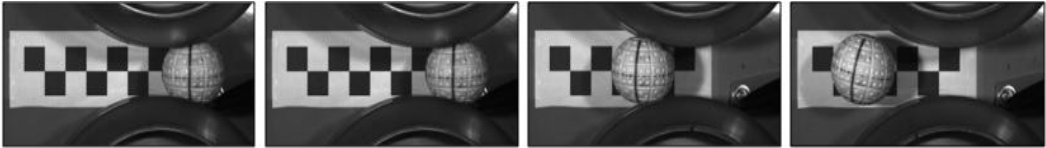
Figure 5. High-Speed images of ball as it enters and exits the pitching